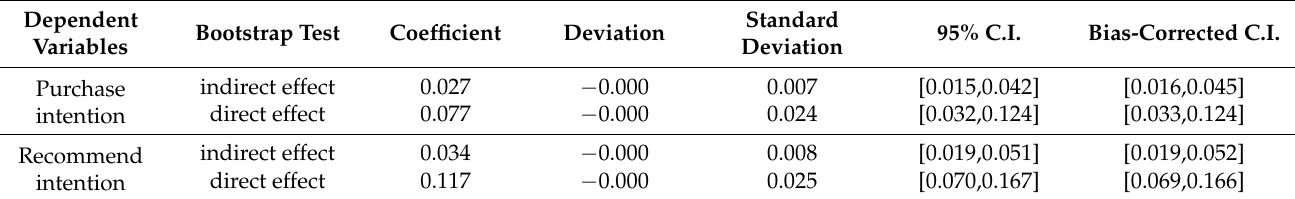
Table 8. Bootstrap test results for mediating effect.